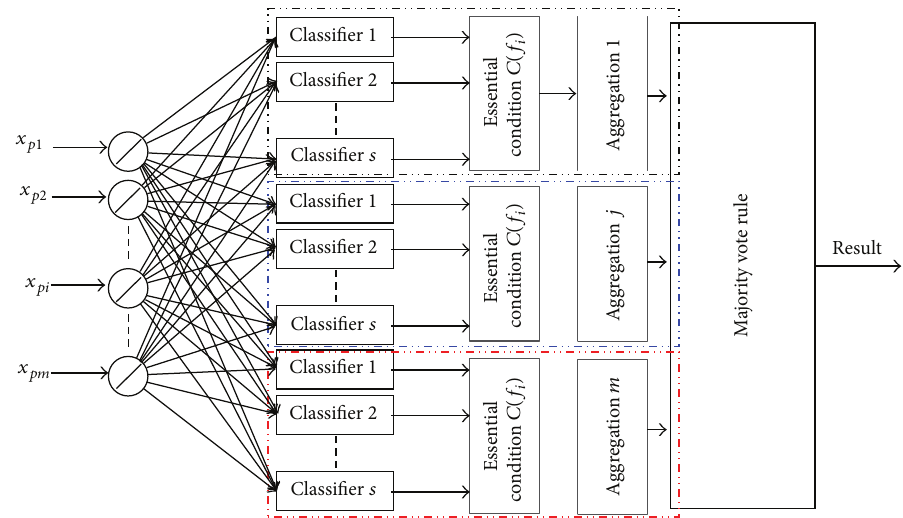
Figure 6: Combining SVM classifiers based on hybrid voting mechanism.